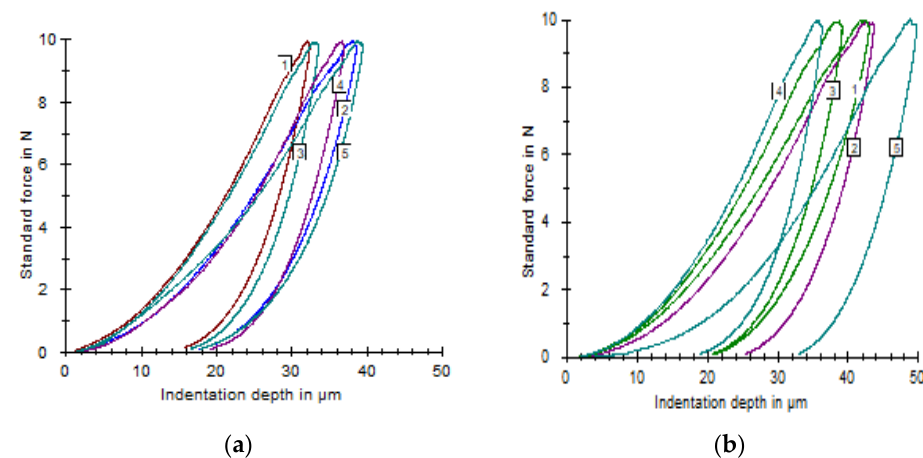
Figure 2. Representative force-indentation depth IIT curves for the dual-cured ( a ) and self-cured ( b ) materials tested. The left peak shifting in dual-cured materials denotes increased HM hardness, whereas the steeper the unloading curve, the higher the indentation modulus (E IT ). 1: PSP, 2: PSU, 3: PV5, 4: SPC, 5: THC.